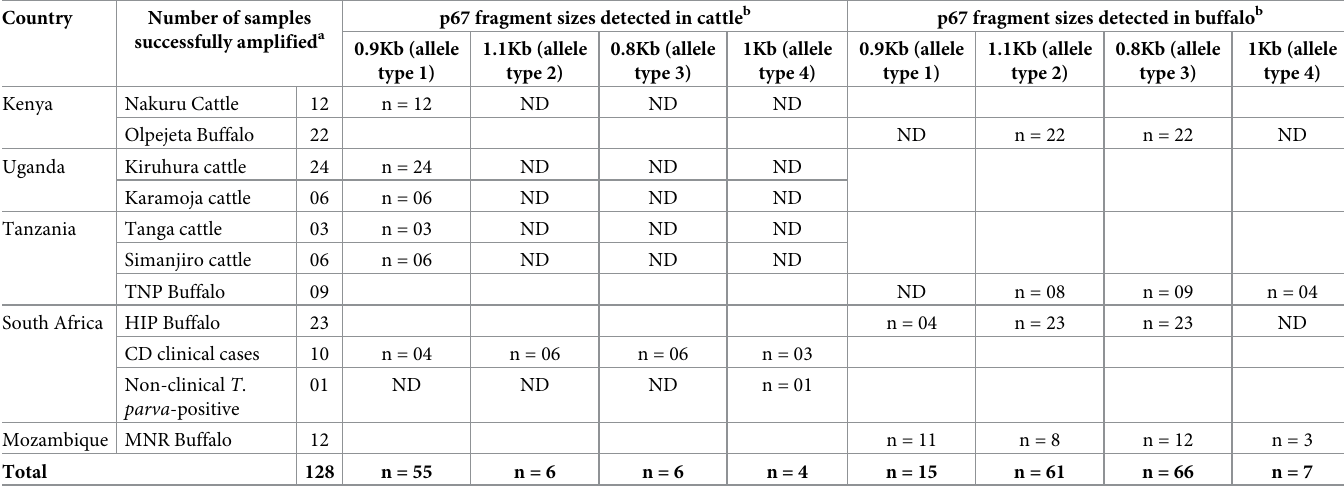
Table 2. PCR amplified p67 fragments detected in T . parva positive samples from cattle and buffalo. Country